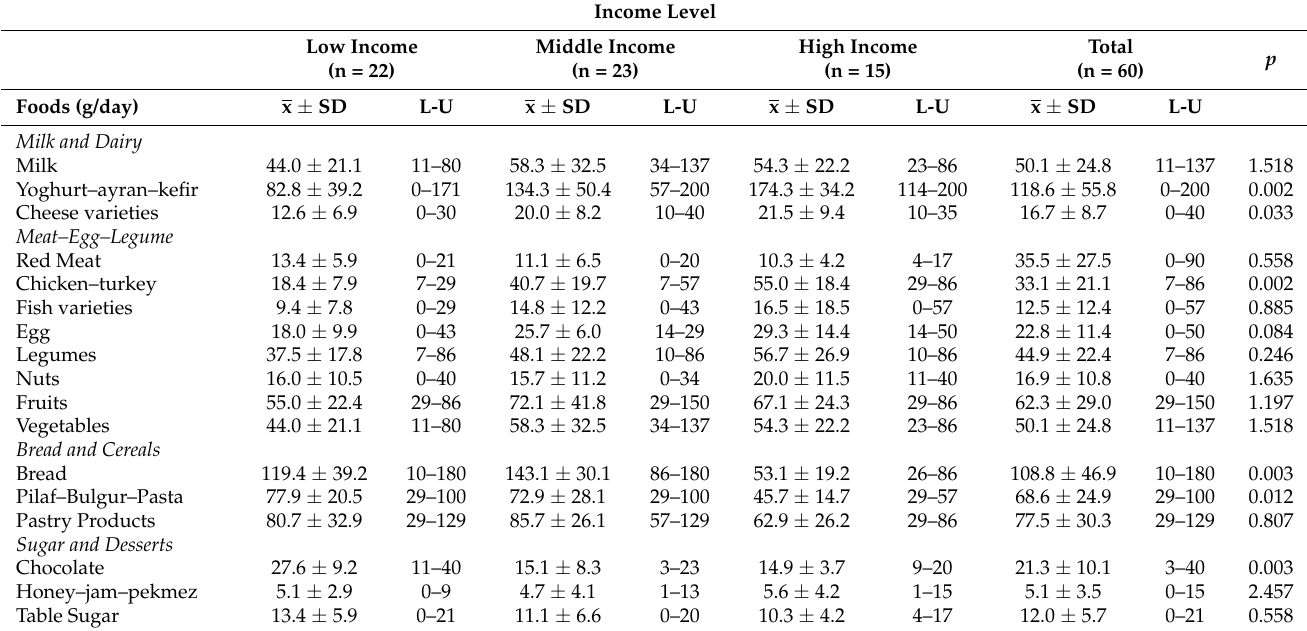
Table 7. Food group consumption in students living in the dormitories stratified by